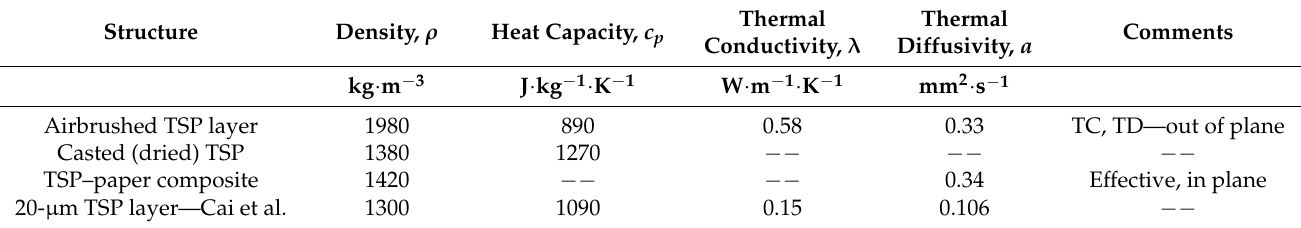
Table 3. The TSP thermal parameters at room temperature versus the data presented by Cai et al. [15]. Structure Density,